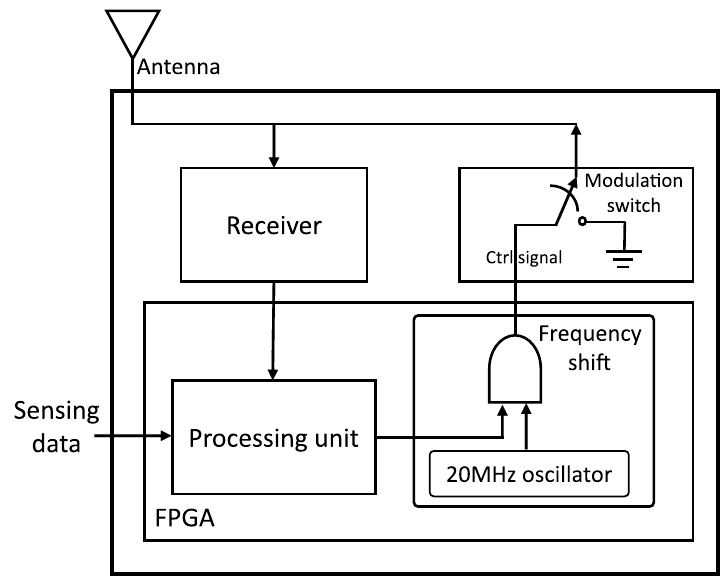
Figure 2. Tag system with